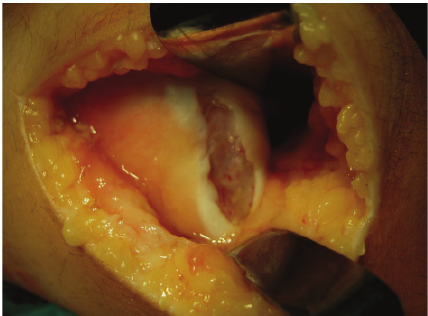
Figure 2: Image of the osteochondral lesion at the weight-bearing surface of the lateral condyle in the same patient.